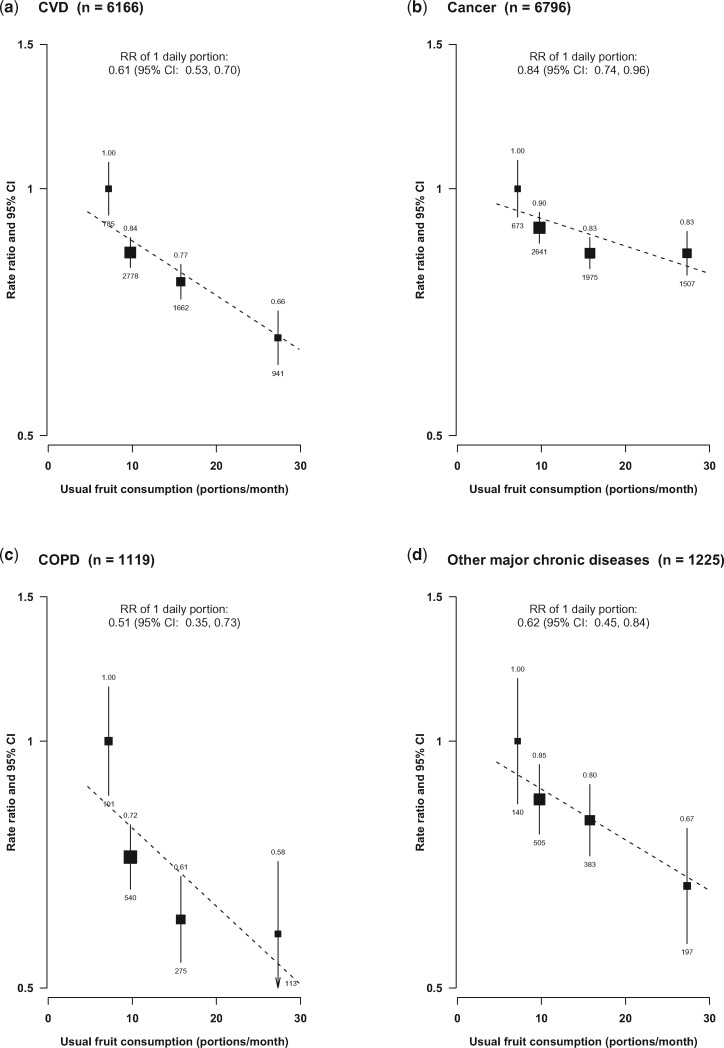
Adjusted RRs for major causes of mortality by levels of fresh fruit consumption. Conventions as in Figure 1. Analyses were stratified by sex, age-at-risk and study area, and adjusted for the same variables as in Figure 1.